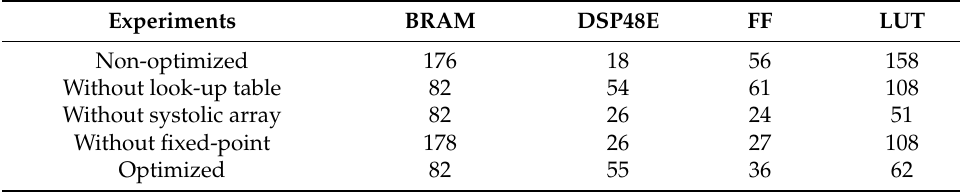
Table 3. Resource utilization when deploying different optimization methods.